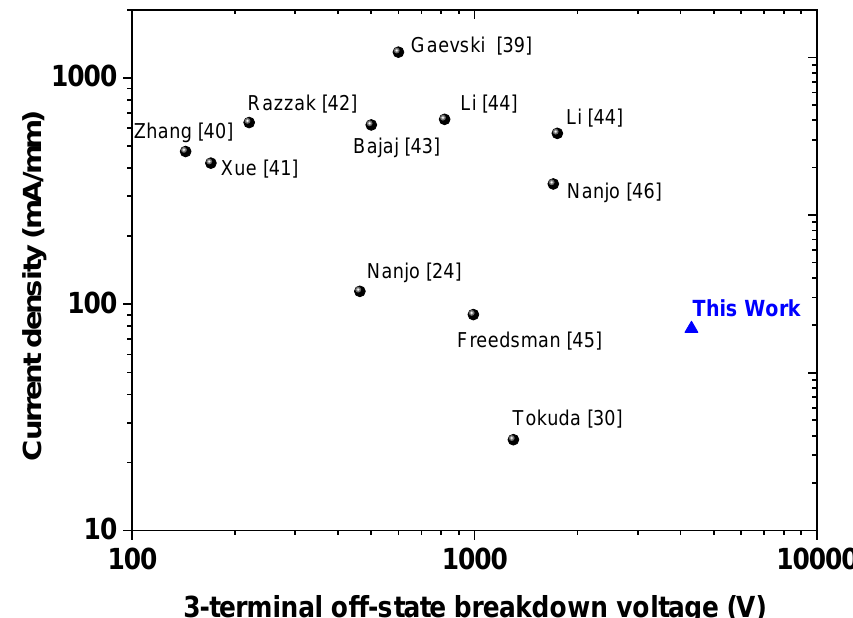
Figure 7. Benchmark of AlGaN channel HEMT devices in terms of current density and 3-terminal breakdown voltage [39–46].